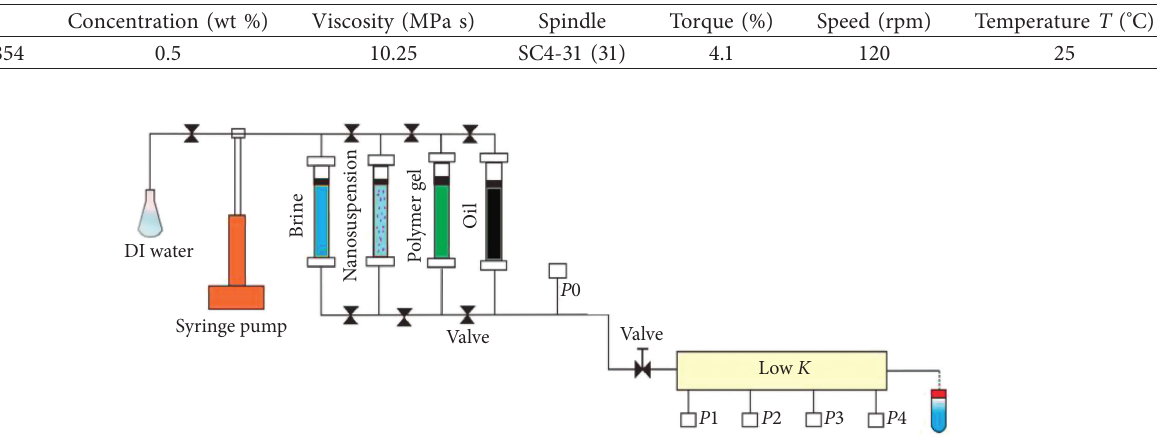
Figure 2: Sand pack schematic diagram.